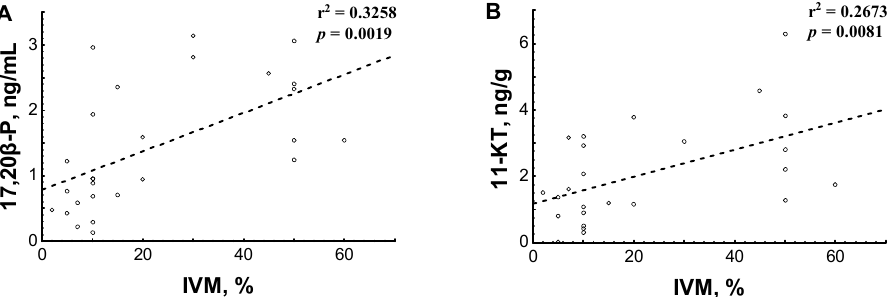
Figure 6. Relationship between sterlet testicular sperm motility percentage after in vitro maturation (IVM) and hormone content in: ( A ) blood plasma, 17,20 β -dihydroxypren-4-en-3-one (17,20 β -P, ng/mL), and ( B ) gonad, 11-ketotestosterone (11-KT, ng/g gonad). Scatterplots, linear regression lines, coefficient of determination r 2 and p for checking the hypothesis that there is no relationship between hormone content and testicular sperm motility percentage after IVM are presented. The data obtained from all experimental sterlet males are